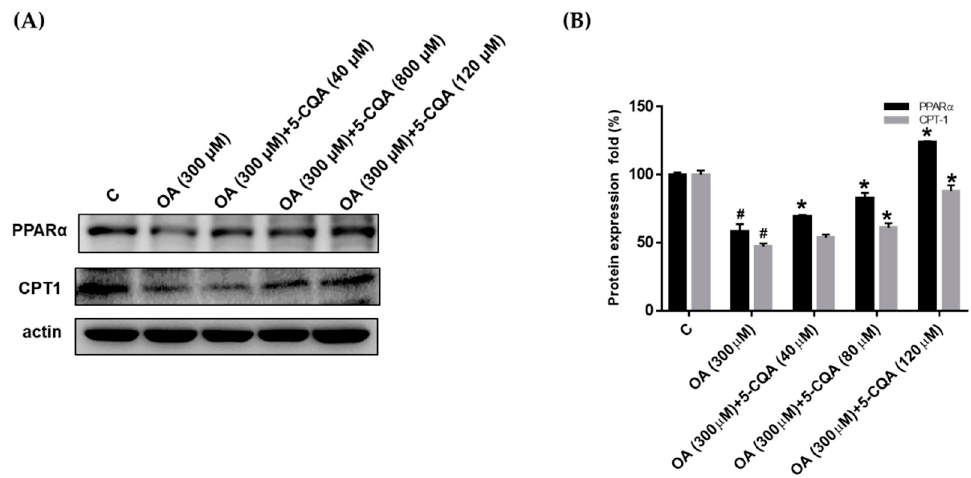
Figure 5. 5-CQA increased the expression of enzymes involved in fatty acid oxidation. ( A ) Cultured cells were treated with OA with or without 5-CQA (40, 80, or 120 µ M) for 24 h. Protein expression was detected using Western blot analysis against PPAR α and CPT1 antibody, with anti-actin as the internal control. ( B ) The data are represented as mean ± SD from three samples for each group. # p < 0.05, in relation to control group. * p < 0.05, in relation to OA-induced group.